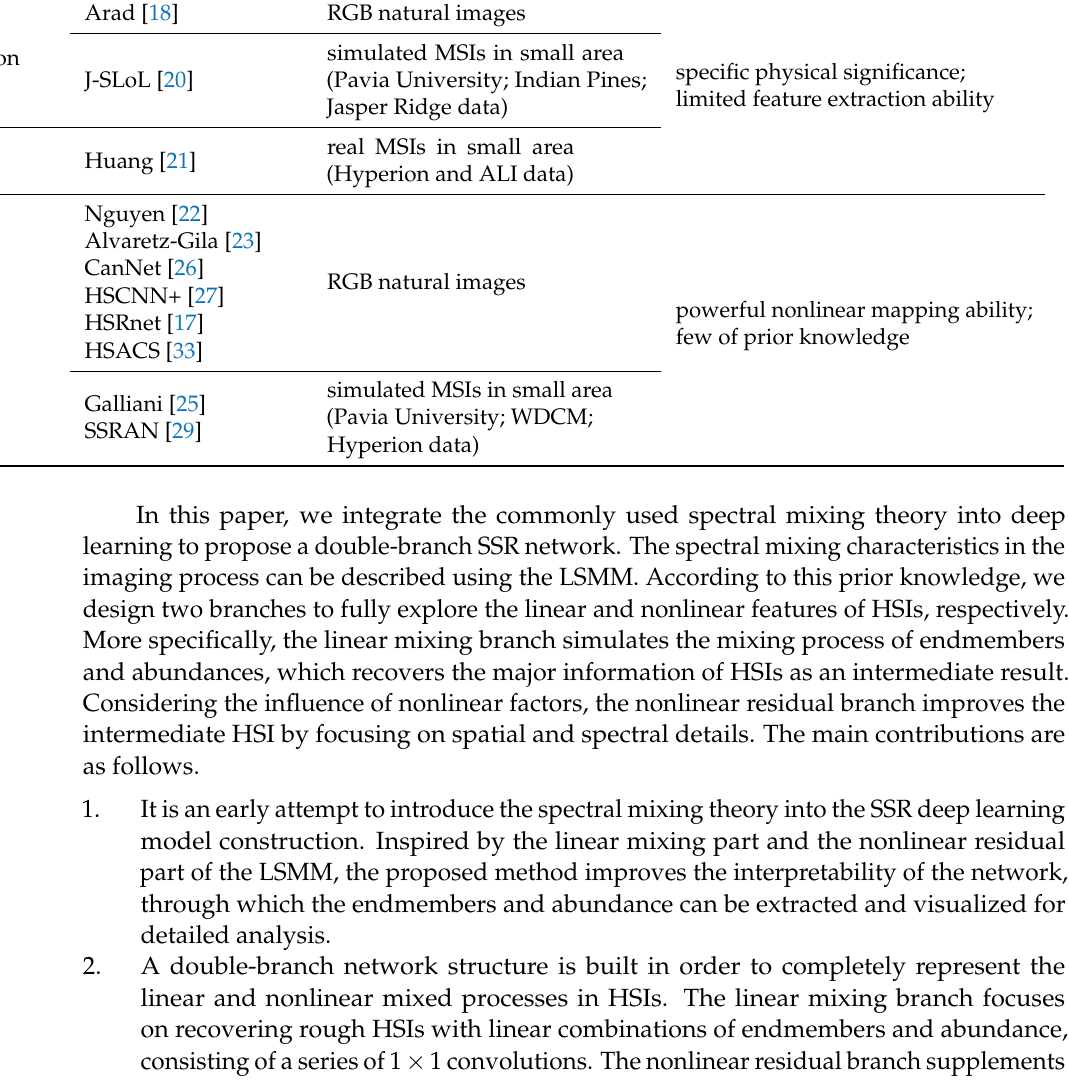
Table 1. A summary of traditional and deep learning based spectral super-resolution methods. Method Model